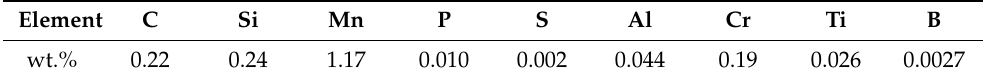
Table 1. The chemical composition of 22MnB5 steel without the Al-Si coating, as measured by OES. Element C Si Mn P S Al Cr Ti B wt.% 0.22 0.24 1.17 0.010 0.002 0.044 0.19 0.026